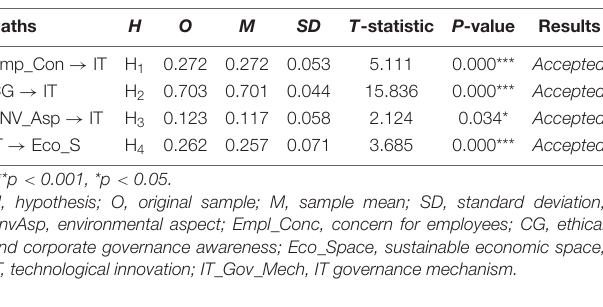
TABLE 6 | The direct effects of the